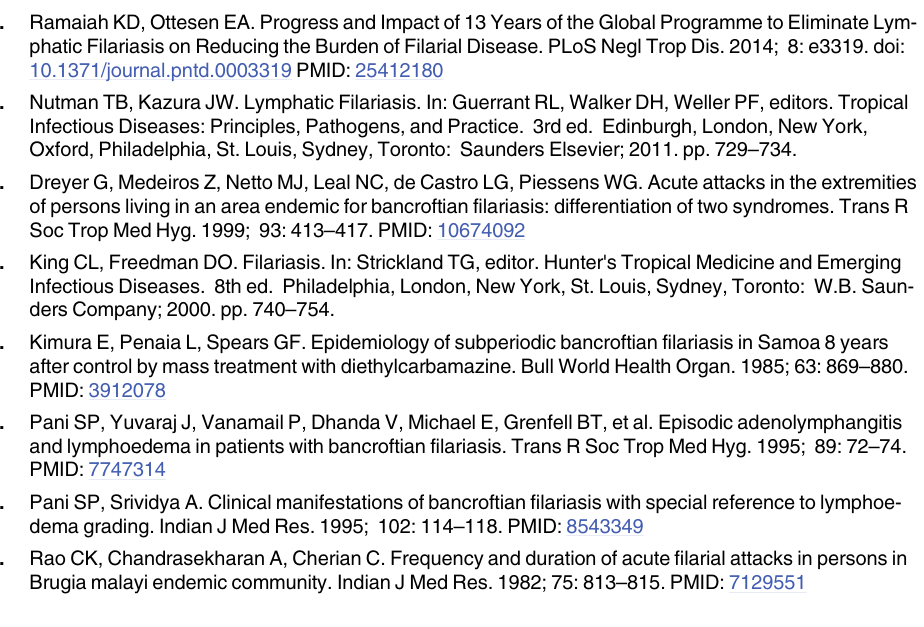
S1 Table. Variation of serum antibody levels due to subject, time, and time conditional on subject among lymphedema patients in Léogâne, Haiti. N = 104 samples. S2 Table. Demographic and clinical characteristics of lymphedema patients in Léogâne, Haiti, comparing the entire cohort to the ADL